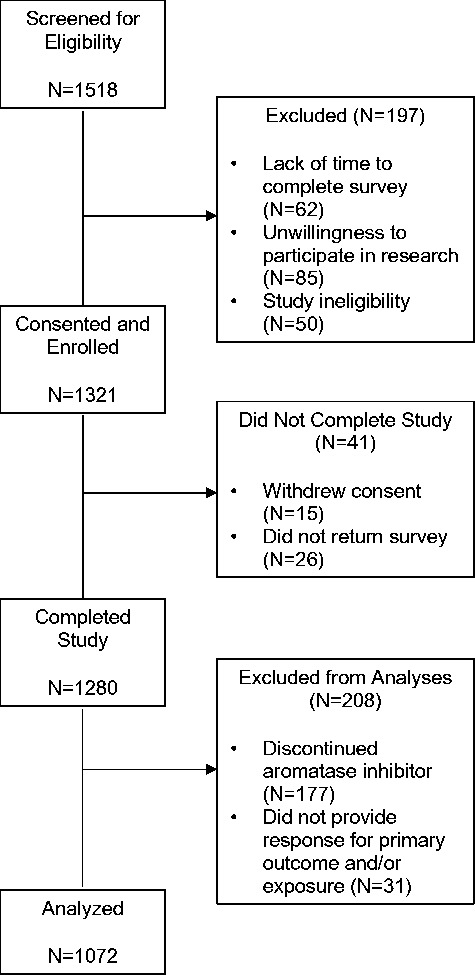
Screening, enrollment, and completion of study.